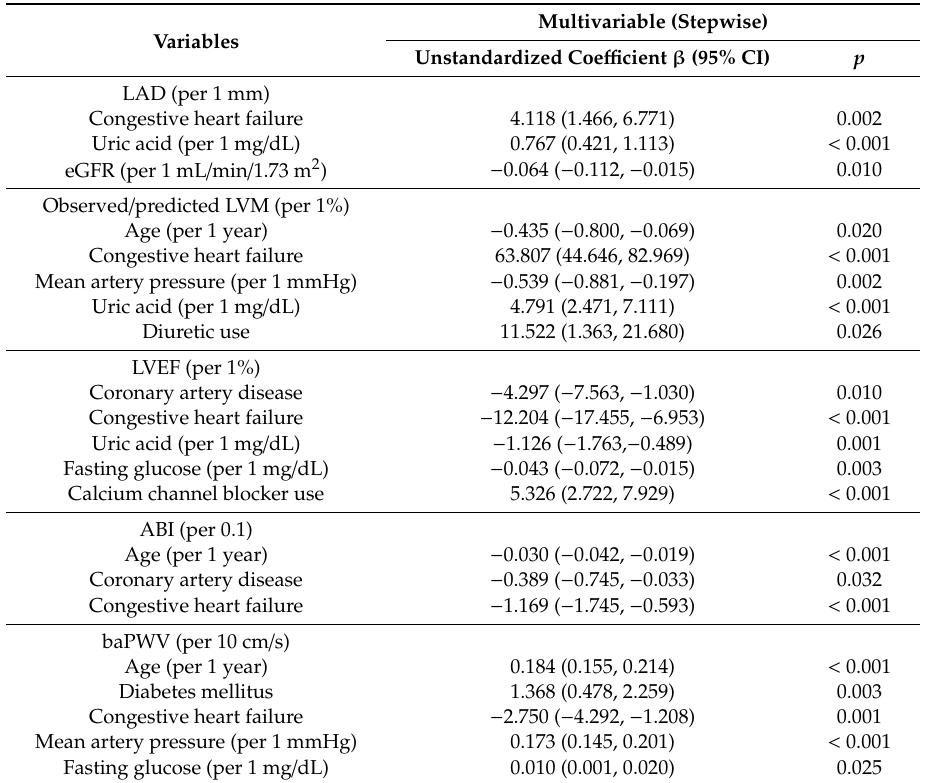
Table 3. Determinants of ABI, baPWV and echocardiographic parameters of study patients using linear regression